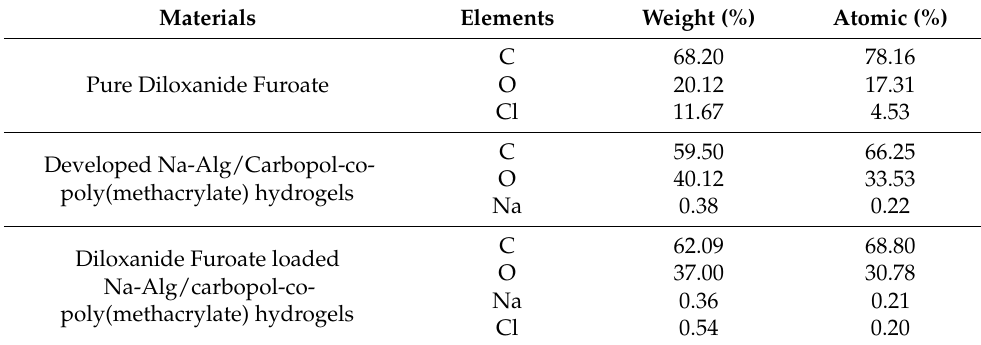
Figure 9. EDX spectra of Diloxanide Furoate, unloaded Na-Alg/CP-co-poly(methacrylate) hydrogel, DF-loaded Na-Alg/CP-co-poly(methacrylate) hydrogel. Table 2. Elemental Composition of pure DF, unloaded, and DF-loaded networks.